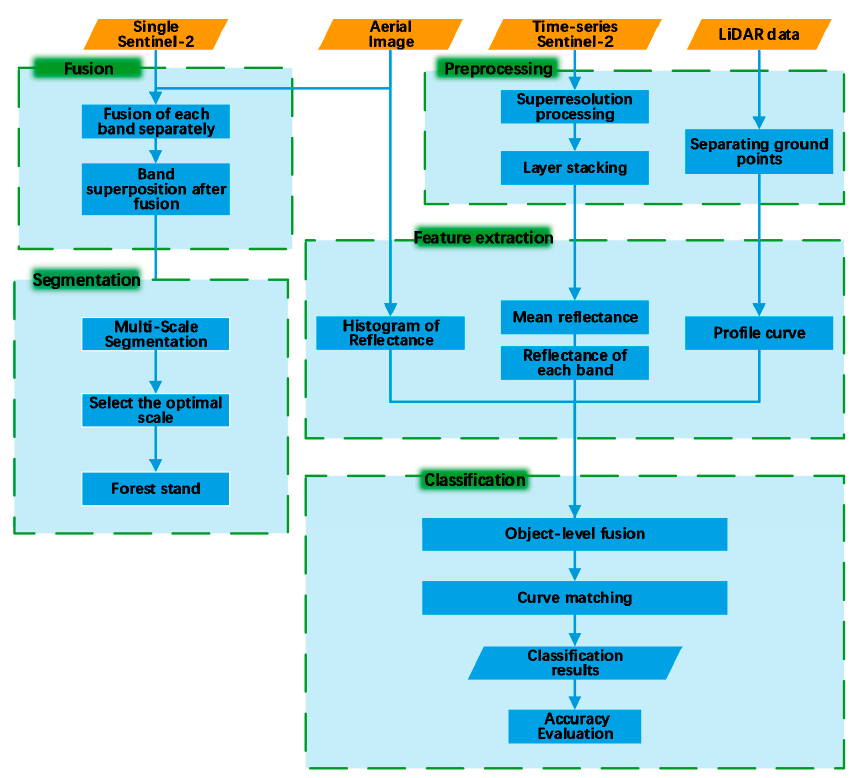
Figure 4. The flowchart of the fusion of spectral image and point data (FSP) method.